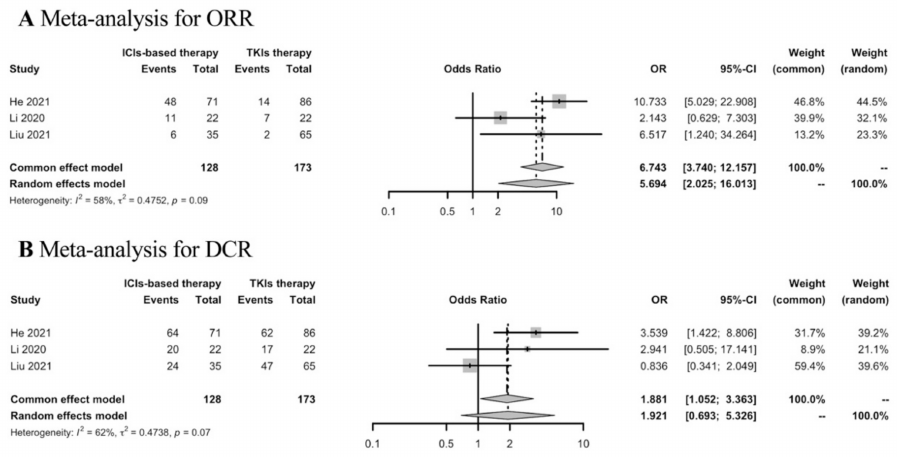
Figure 3. Meta-analysis of response rates in advanced HCC patients receiving first-line ICIs-based therapy versus TKIs therapy.